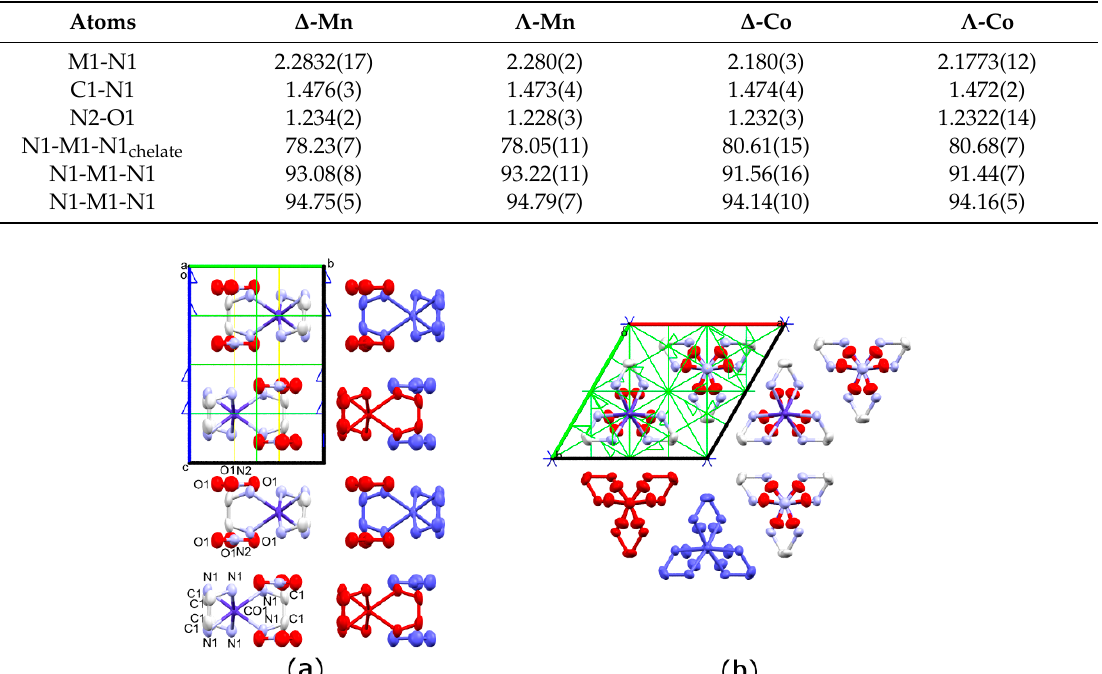
Figure 1. Anisotropic displacement ellipsoid diagram (Mercury, 50% probability) of Δ -[Co(en) 3 ](NO 3 ) 2 at 298 K as viewed down the ( a ) a crystal axis and ( b ) c crystal axis. Unit cell and symmetry axes are shown, with blue = six-fold screw, yellow = three-fold and green = two-fold axes. Two different columns are indicated by red and blue molecules. Hydrogen atoms have been omitted for clarity.